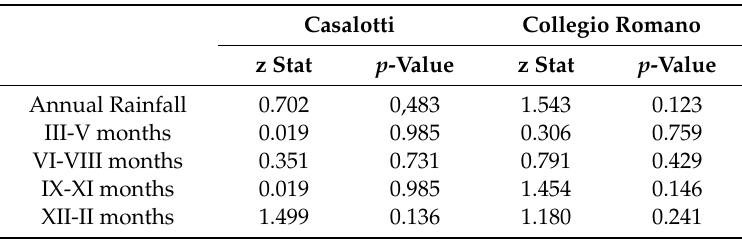
Table 2. Mann-Kendall statistics: z -values and p -values related to the annual and seasonal precipitation time series for urban (Collegio Romano) and rural (Casalotti) sites. Casalotti Collegio Romano z Stat p -Value z Stat p -Value Annual Rainfall 0.702